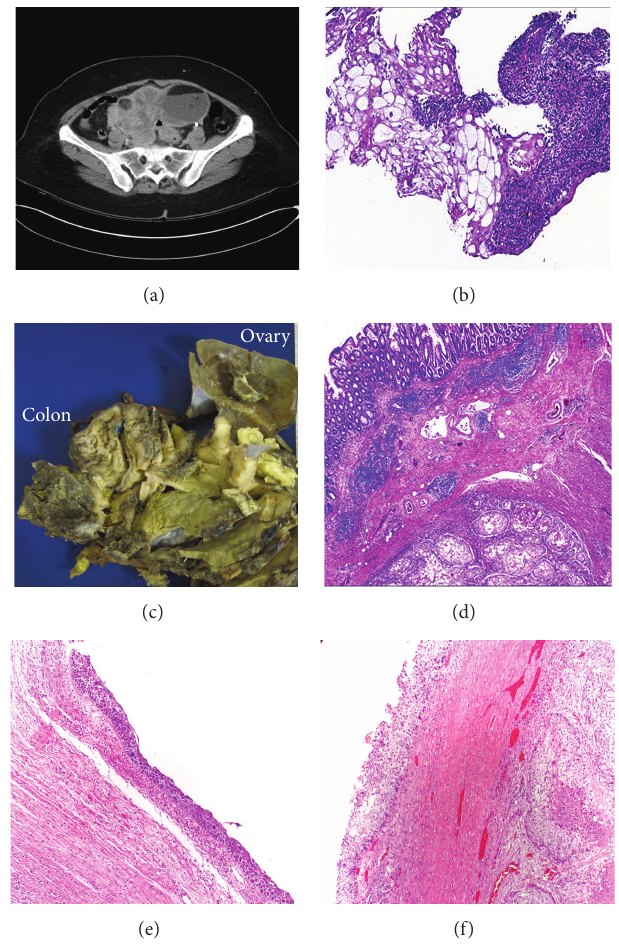
Figure 2: (a) Pelvis CT showing a mass with a cystic and solid component and internal septations. (b) Colon biopsy revealing an atypical squamous epithelium, suspicious for well-differentiated squamous cell carcinoma (H&E, 40x). (c) Gross picture showing a cystic ovarian mass (right) and (d) squamous cell carcinoma invading colonic wall (H&E, 20x). (e) In situ squamous cell carcinoma (H&E, 10x). (f) In situ squamous cell carcinoma and invasive component (H&E,